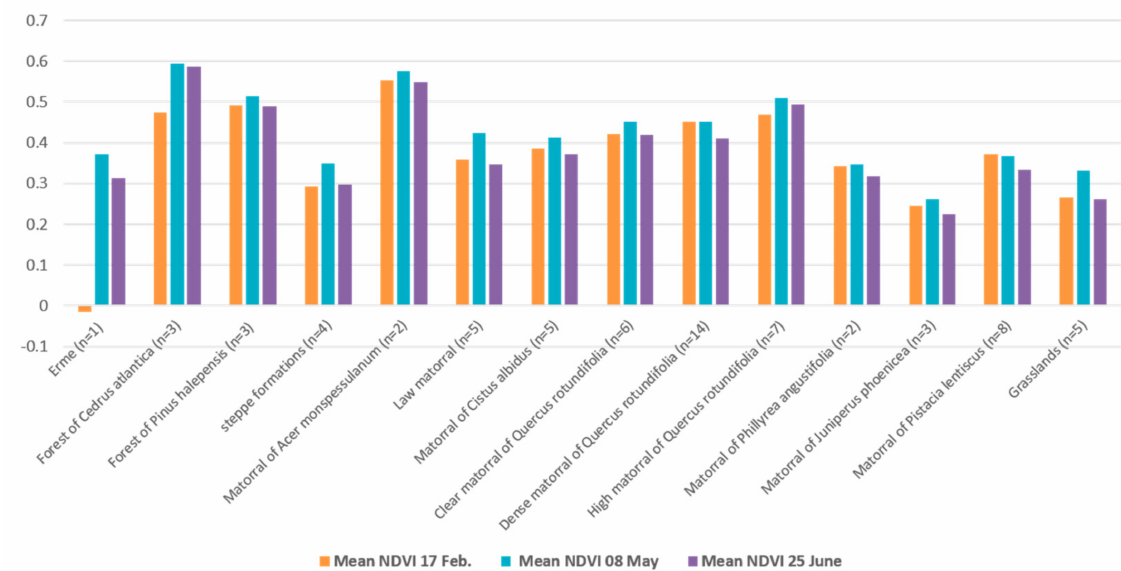
Figure 6. Average NDVI by plant formation type and for each image